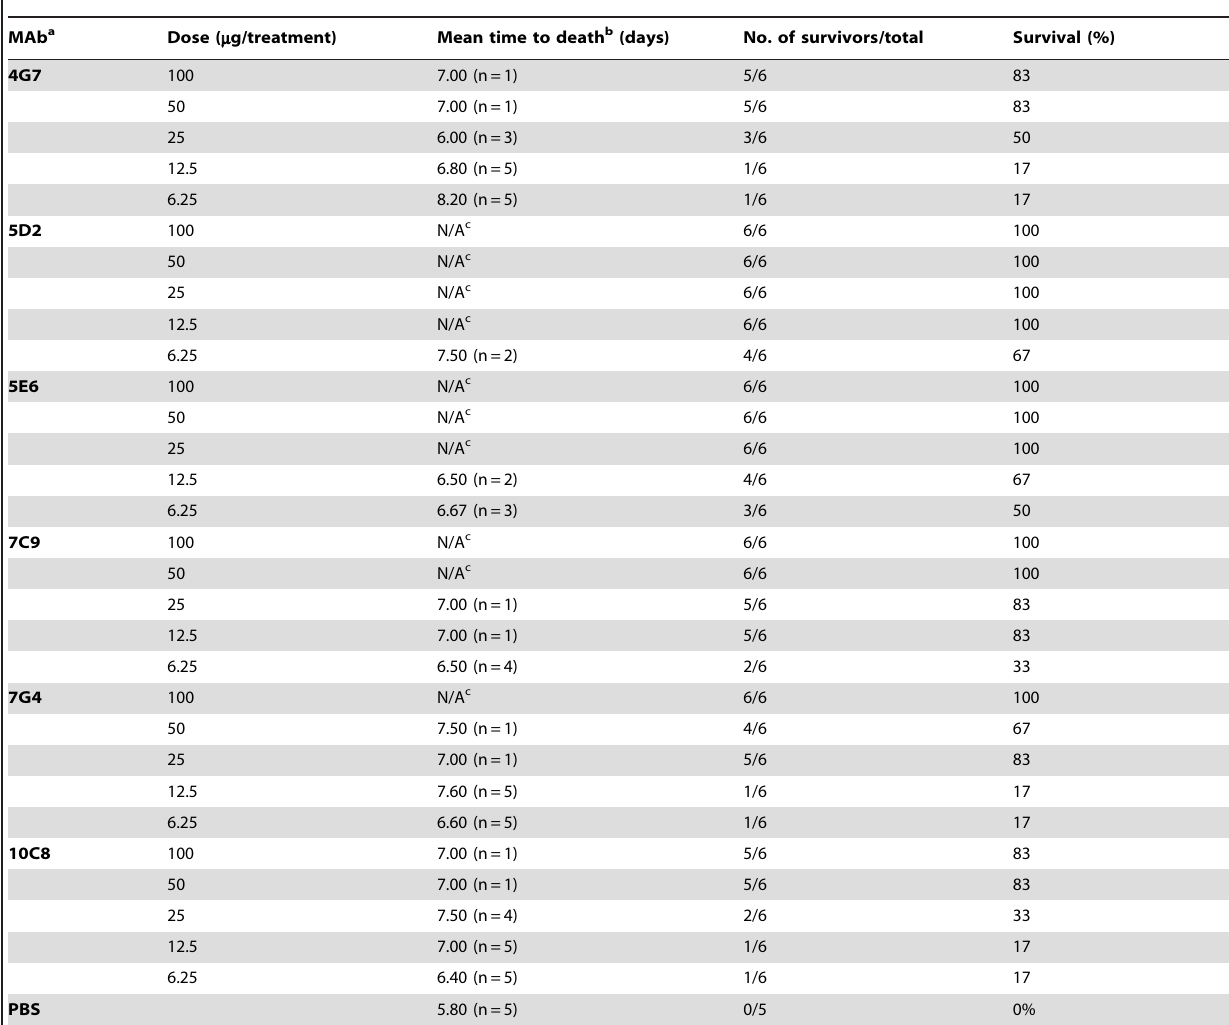
Table 2. Dose-dependent protective efficacy of MAbs in mice.